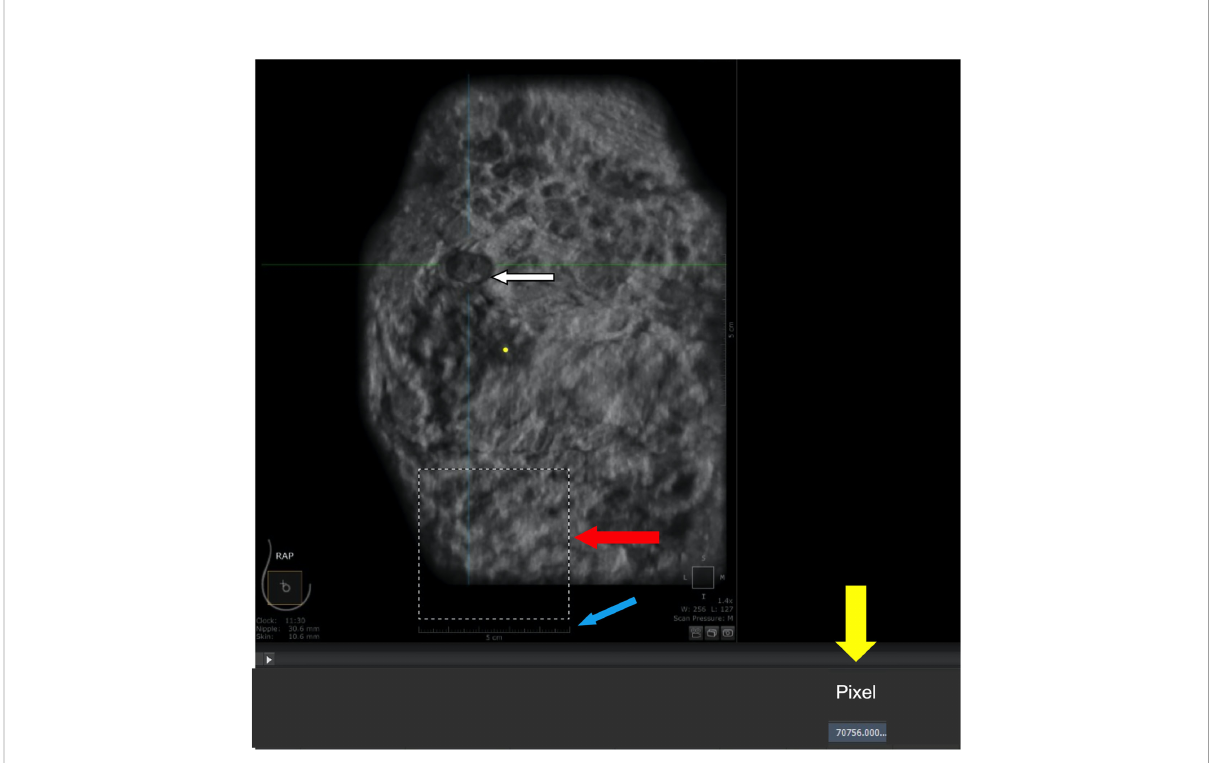
FIGURE 1 Calculation of area-to-pixel ratio using Adobe Photoshop CS6 software. (A) scale bar (5 cm). (B) square with a length of 5 cm and actual area of 25 cm 2 . (C) number of pixels (70756) automatically counted by the software within the outlined region. (D)